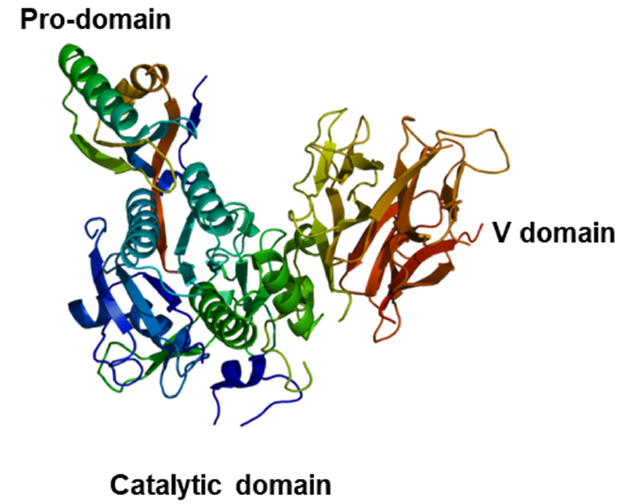
Figure 2. PCSK9 chemical structure. The structure of PCSK9 reveals four major components in the pre-processed protein: the signal peptide (residues 1–30); the N-terminal pro-domain (residues 31–152); the catalytic domain (residues 153–425); and the C-terminal domain (residues 426–692), which is further divided into three modules.